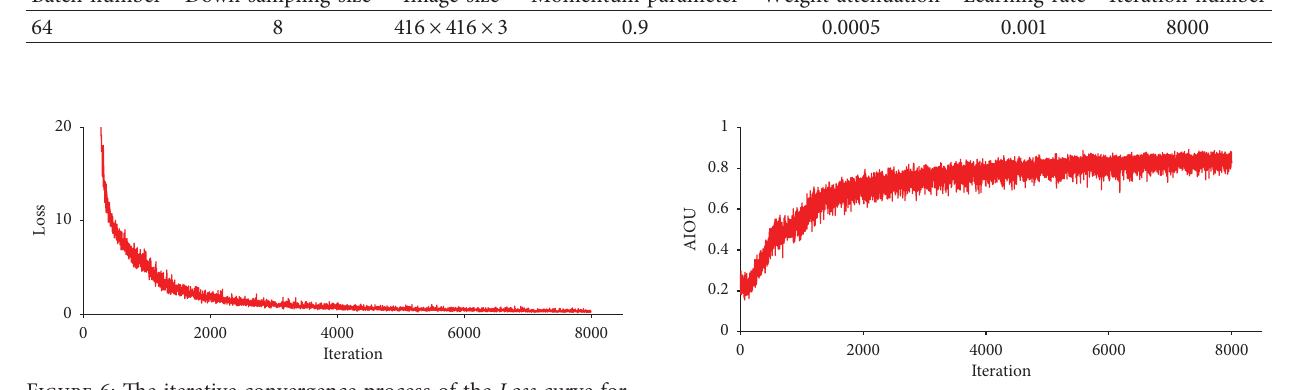
Figure 9: The iterative convergence process of the AIOU curve for YOLOv3 network training. Table 4: The comparison of performance indexes between YOLOv2/v3 after 8000th